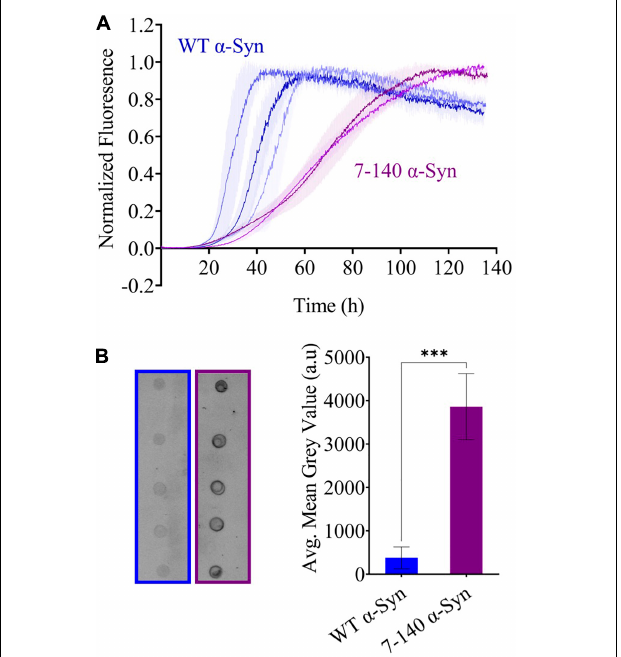
FIGURE 3 | (A) Beaded aggregations of WT (blue) and 7–140 (purple) α -syn. WT and 7–140 α -syn have t 1 / 2 values of 38 ± 7 and 69.7 ± 0.7 h and t lag values of 28 ± 6 and 31 ± 6 h, respectively. Each data set is the average of the normalized technical replicates ( n ≥ 3, error bars are the standard deviation of the mean). Three independent replicates for WT α -syn and two independent replicates for 7–140 α -syn are shown. (B) Dot blots (left) and quantifications (right) of the soluble fractions after aggregation of WT (blue) and 7–140 (purple) α -syn after aggregation ( n = 5, values represent means and error bars are the standard deviation, Welch’s t -test ∗∗∗ p = 0.0002).